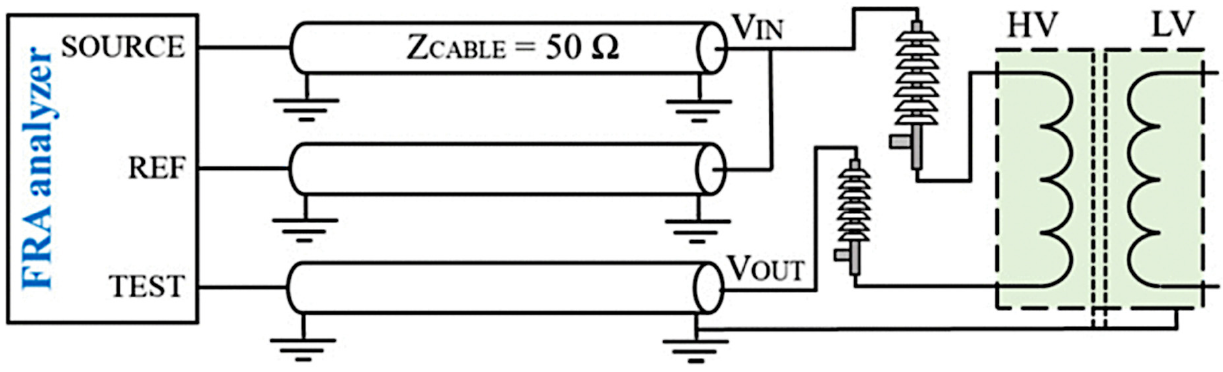
Figure 2. FRA measurement setup.